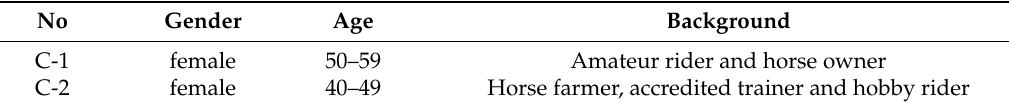
Table 3. Demographics and equestrian experience of the authors.